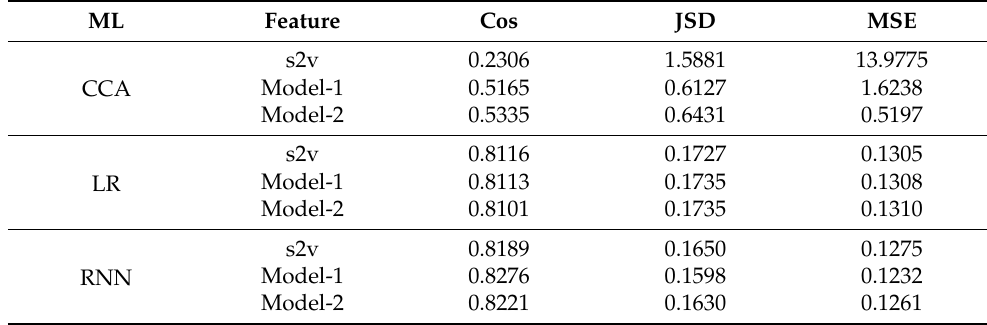
Table 17. Comparison of cosine, JSD, and MSE